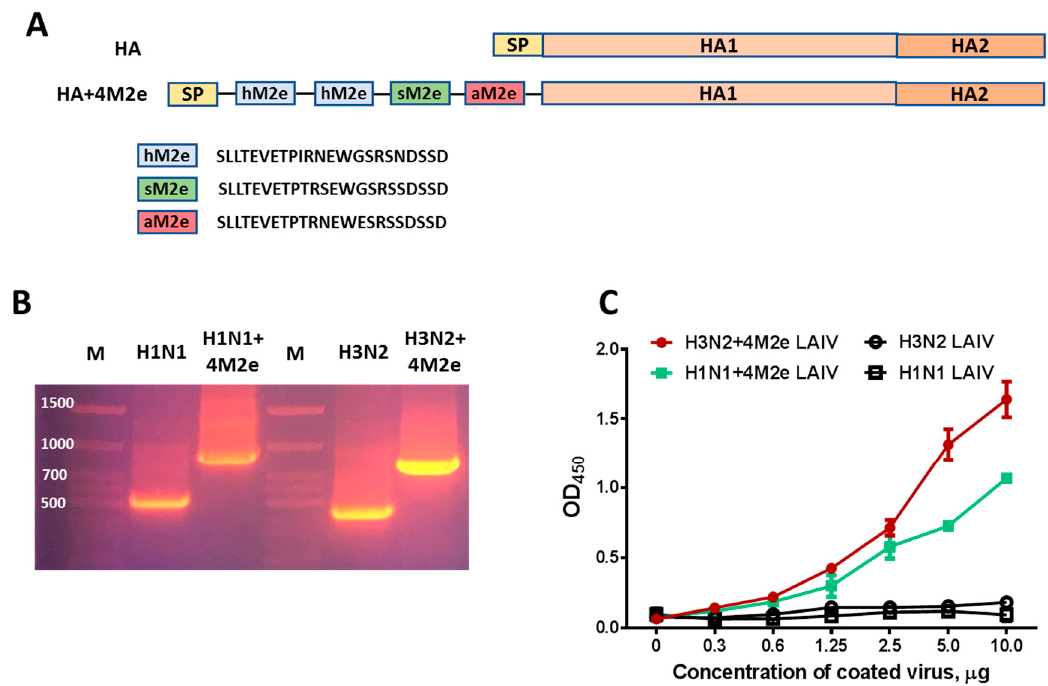
Figure 1. Chimeric live attenuated influenza vaccine (LAIV)+4M2e LAIV viruses generated in